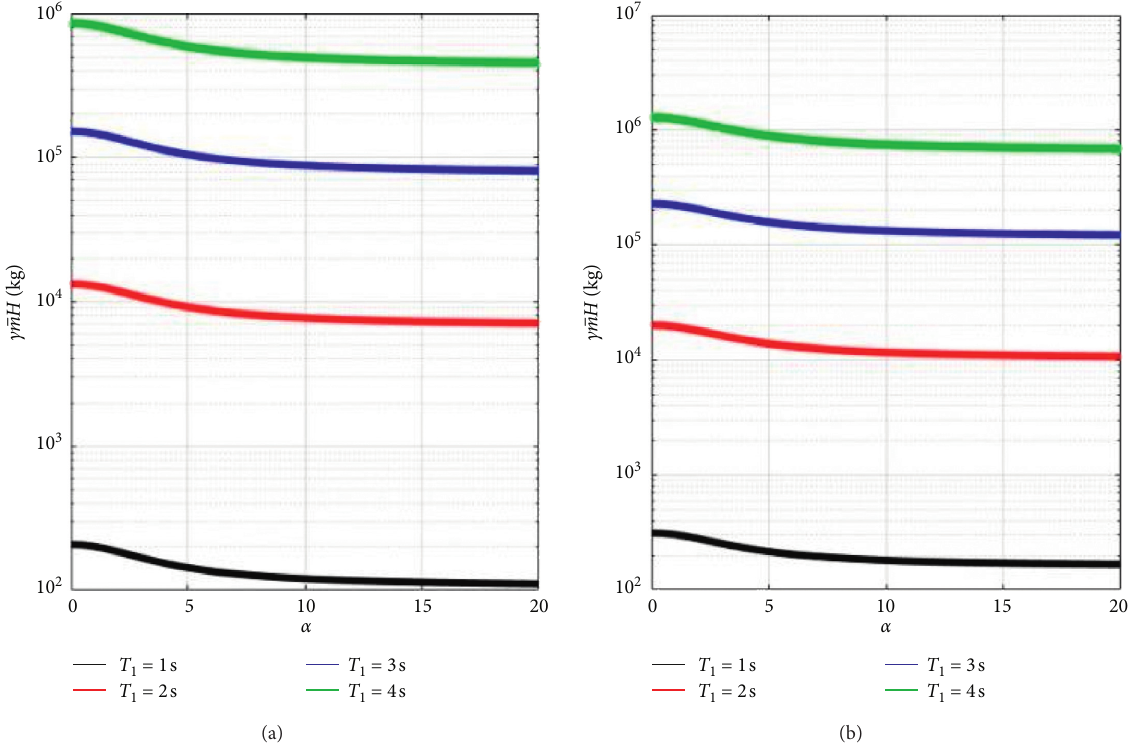
Figure 5: Maximum efficient moving mass of a single TSD attached at z ( a � b ). Table 4: Geometry and equivalent TMD mass of a single TSD attached at z